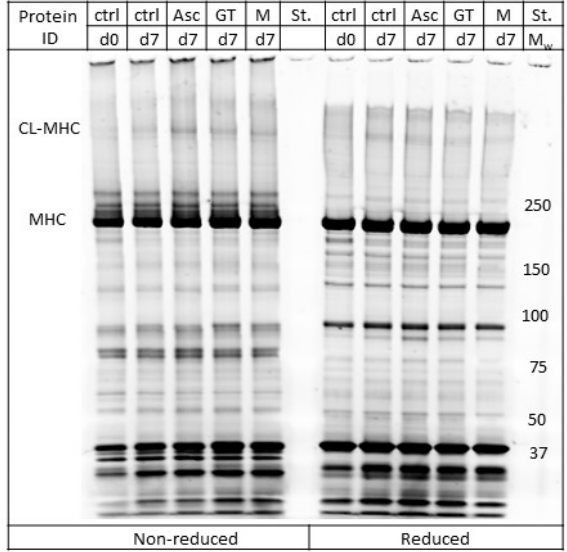
Figure 2. Representative SDS-PAGE of pork loins injected with neutral brine (ctrl) and chill stored in high-oxygen modified atmosphere packaging (MAP) for 0 (d0) or 7 days (d7), and pork loins injected with brine added 225 ppm ascorbate (Asc), green tea extract (GT; ~25 ppm gallic acid equivalents (GAE)), or maté extract (M; ~25 ppm GAE), and chill stored in high-oxygen (MAP) for seven days (d7). Samples were run both in their non-reduced state and reduced state. CL-MHC, cross-linked myosin heavy chain; MHC, myosin heavy chain.